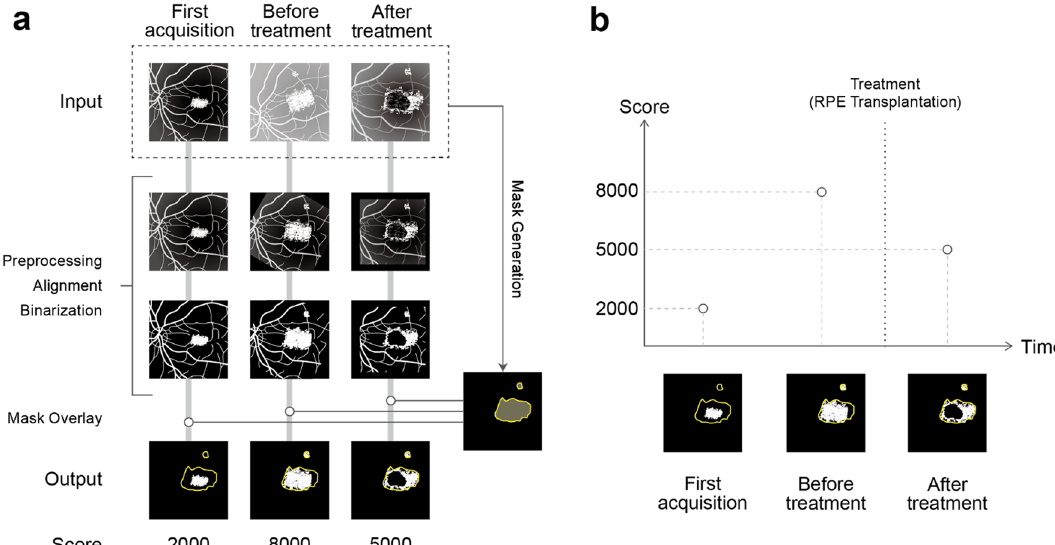
Figure 1. Developed software overview. ( a ) This program outputs Scores by automatically performing the following operations using FA images as inputs: position adjustment, brightness adjustment, binarization, and extraction of Abnormal regions by applying the program obtained by deep learning. ( b ) The developed program automatically calculates a Score based on the Hyperfluorescent area on FA images acquired from a patient over